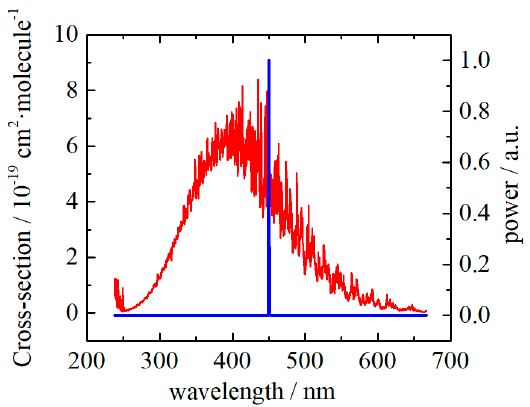
Figure 1. NO 2 absorption cross-section in the range from 240 to 670 nm, compared with the laser emission spectrum. The laser has a peak emitting power at 450 nm when the case temperature is 25 ◦ C, and the wavelength drift is about 0.067 nm · ◦ C − 1 .